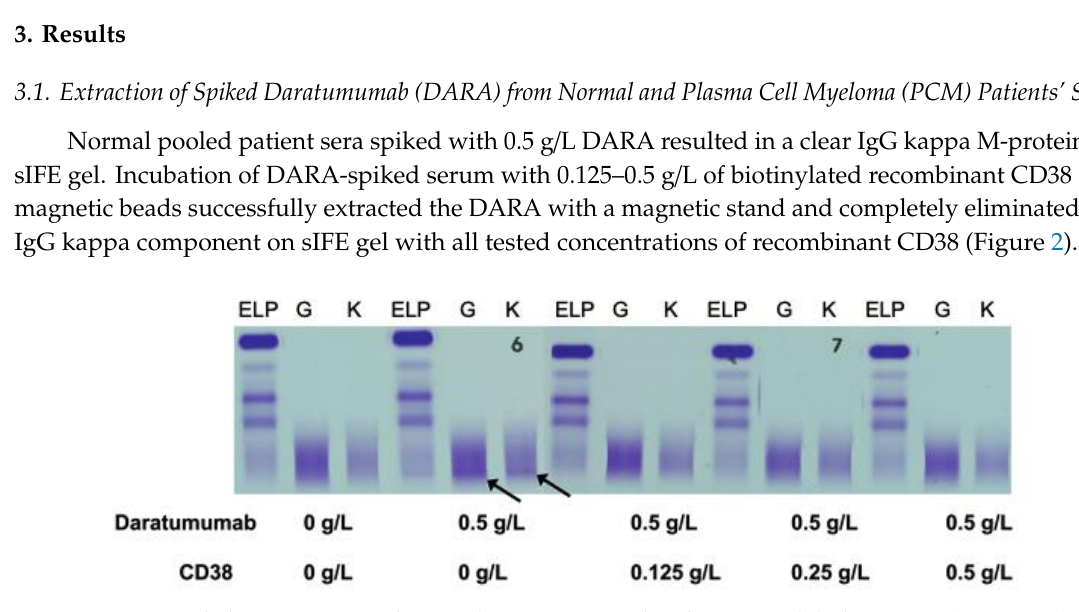
Figure 2. Pooled patient sera with no endogenous monoclonal immunoglobulin protein (M-protein) spiked with DARA resulted in a clear IgG (G) kappa (K) M-protein (indicated by arrows) on serum immunofixation (sIFE) gel. Incubation of DARA-spiked serum with 0.125–0.5 g/L of biotinylated recombinant CD38 and magnetic beads successfully extracted the DARA with a magnetic stand and completely eliminated the IgG kappa component on sIFE gel with all tested concentrations of recombinant CD38.